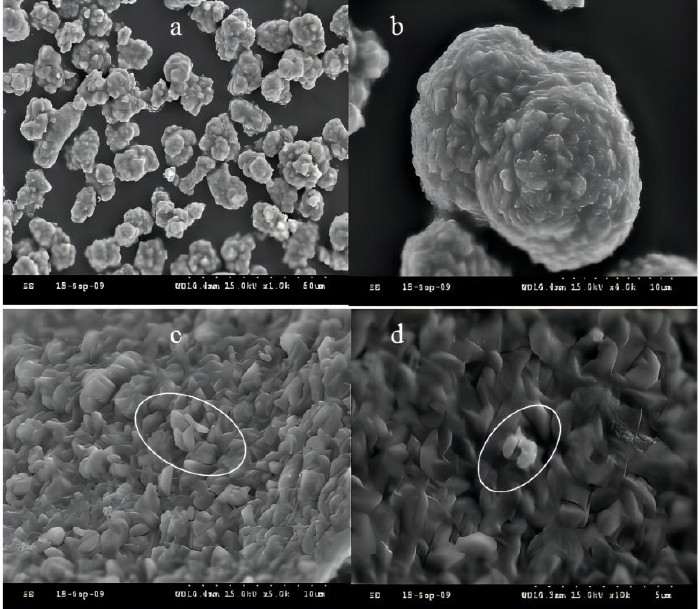
Figure 3. Scanning electron micrograph of jarosite formed in the presence of A. ferrooxidans (( a ) ×1000; ( b ) ×4000; ( c ) ×5000; and ( d ) ×10,000).